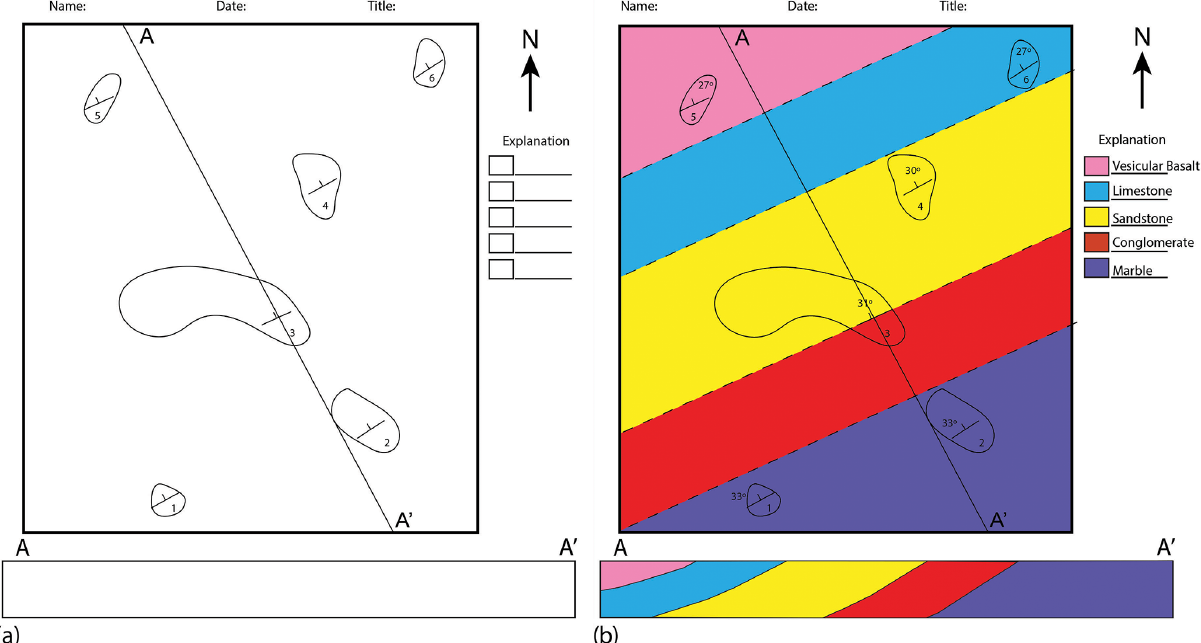
Figure 4. The before and after examples of Map 1. (a) Students were initially given a blank map with space to fill in the explanation and cross section. Students were expected to fill in field notes and interpretation of geologic events on a separate piece of paper. Panel (b) shows a completed map and the accompanying cross